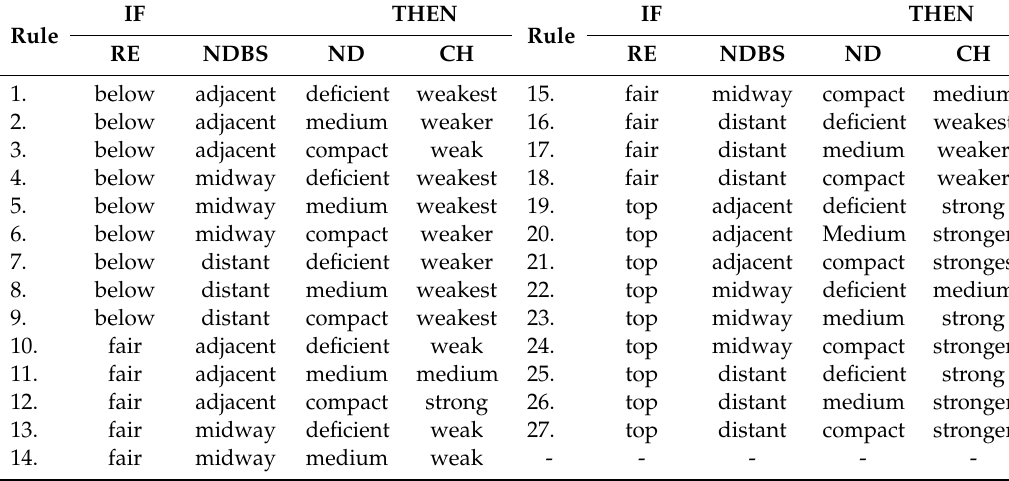
Figure 4. Membership function of CH (chance). Table 1. Fuzzy knowledge database